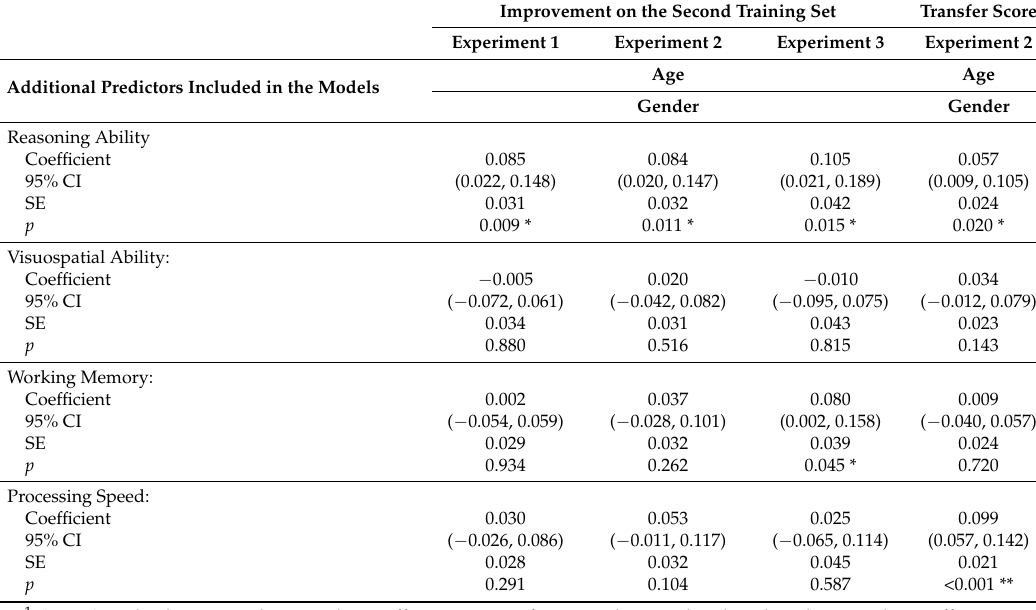
Table 4. Results of Linear Models That Regressed the Learning Measures on Each Fluid Ability and Controlled for Age and Gender 1 .